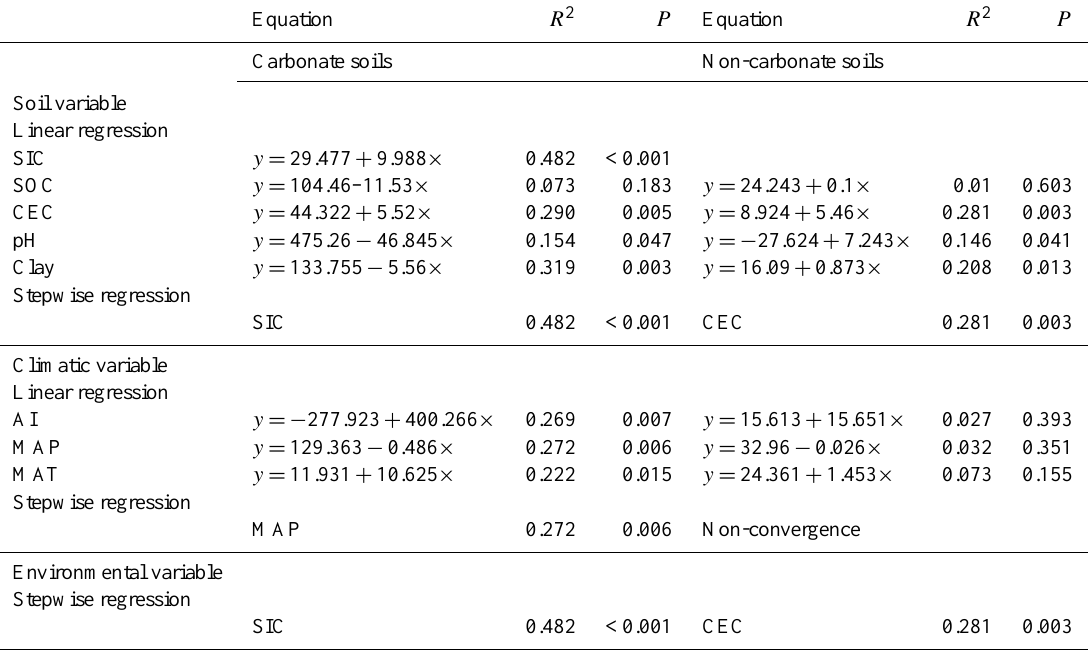
Table 2. Summary of regression models (linear and stepwise) for the effects of soil, climatic and all environmental variables on soil pH buffering capacity in the carbonate-containing soils and the non-carbonate-containing